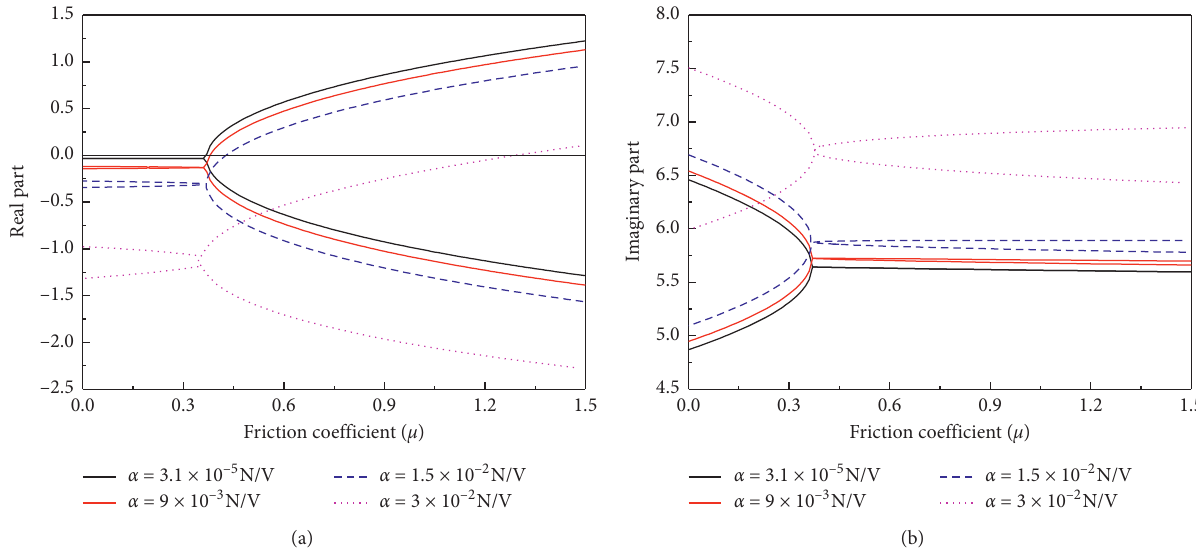
Figure 20: The real parts (a) and imaginary parts (b) of the friction system with different force factors of piezoelectric